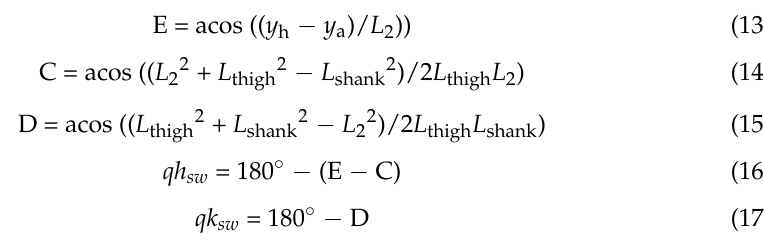
Figure 5. State machine of ankle torque. Tankle indicates ankle torque, and T indicates the ankle torque during the push-off phase. LFn and RFn represent ground reaction forces. Inter_hip de- notes the angle between the two legs. H_diff is defined by the difference between the toe and the heel of the swing leg. 3. Controller 3.1. Controller Framework of the Ankle Joint The controller framework of the ankle joint during the single gait cycle is presented in Figure 5. The ankle torque of the biped robot during the single gait cycle mainly in- cludes two stages: the stance stage and the swing stage. The stance stage includes the early stance stage and the push-off stage. When the stance leg is at the early stance stage and the ankle joint is in the passive mode, the ankle torque is 0. As the swing leg moves for- ward to the initial position of push-off, the ankle joint of the stance leg starts to push-off. The initial position is the state just after the push-off phase; thus, the stance leg is at the early stance phase, and the corresponding ankle torque is 0 N ∙ m. As the stance leg moves forward, when the global variable Q is greater than or equal to the angle b, the inter-leg angle is greater than or equal to a, and the knee angle qk sw of the swing leg is greater than − 5°, the left leg begins to push-off. The torque curve is applied to the ankle joint of the left